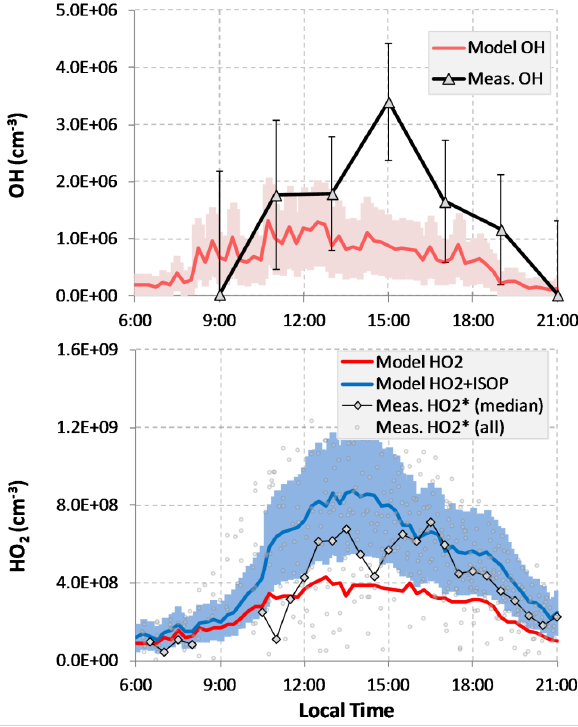
Figure 5: PROPHET 2008 OH and HO 2 * median measurements with the RACM/MIM model results. Measured points are shown as 2 hr medians (OH, triangles) and 30 min medians (HO 2 *, diamonds) for Fig. 5. PROPHET 2008 OH and HO ∗ median measurements with 2 the daytime measurements (6 am – 9 pm). Error bars are the 2-sigma measurement precision for OH, the RACM/MIM model results. Measured points are shown as 2h while the HO 2 * measurement precision (not shown) is approximately ± 2.0 × 10 7 cm -3 . Gray circles in the medians (OH, triangles) and 30 min medians (HO ∗ , diamonds) for bottom plot represent all of the HO 2 * measurements during PROPHET 2008 while the gray diamonds are 2 the daytime measurements (6 a.m.–9 p.m.). Error bars are the 2 σ the 30 minute median for the times of this analysis where HO 2 * measurements are available. The red measurement precision for OH, while the HO ∗ measurement preci- lines represent the base RACM/MIM daytime model results for OH (2σ relative uncertainty ± 50% shad- 2 ed) or HO 2 . The blue lines represent the daytime modeled HO 2 + ISOP (2σ relative uncertainty ± 33% sion (not shown) is approximately ± 2.0 × 10 7 cm − 3 . Gray circles shaded). in the bottom plot represent all of the HO ∗ measurements during 2 PROPHET 2008 while the gray diamonds are the 30 min median for the times of this analysis where HO ∗ measurements are avail- 2 able. The red lines represent the base RACM/MIM daytime model results for OH (2 σ relative uncertainty ± 50% shaded) or HO 2 . The blue lines represent the daytime modeled HO 2 + ISOP (2 σ relative uncertainty ± 33%